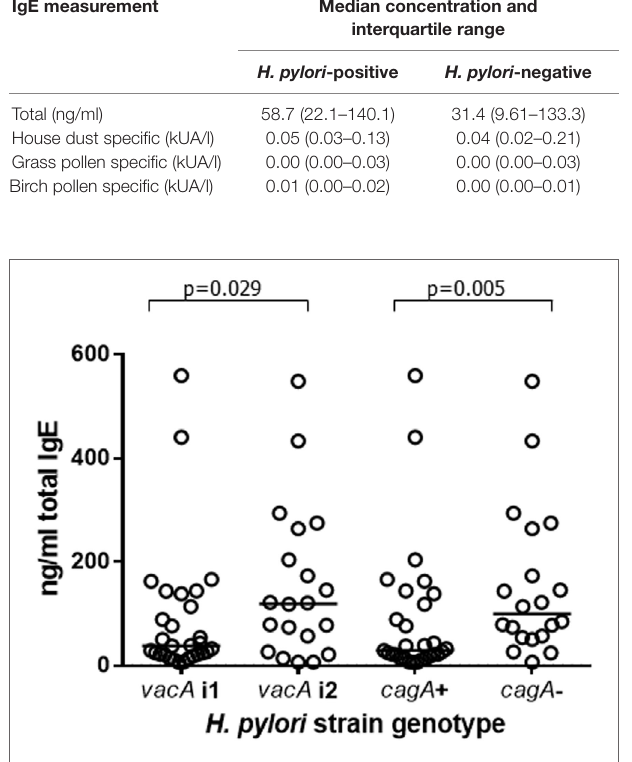
FigUre 4 | Plasma ige concentrations from 49 patients infected with H. pylori strains of differing virulence genotypes . Of the 29 cagA + strains, 24 were of the i1 vacA genotype and 5 were vacA i2. Of the 20 cagA − strains, 15 were vacA i2 and 5 were of the vacA i1 genotype. Points represent the results from individuals and horizontal lines depict the